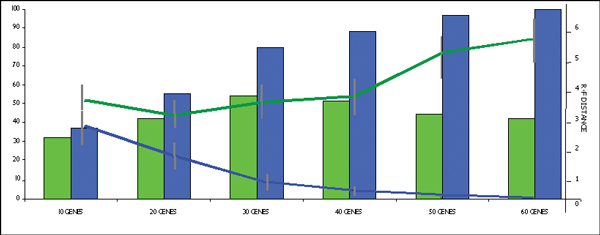
Percentage of genes in each functional category. Colors specify the 'Blochmannia' (red), the 'essential' (green) and the 'universal' (blue) cores.